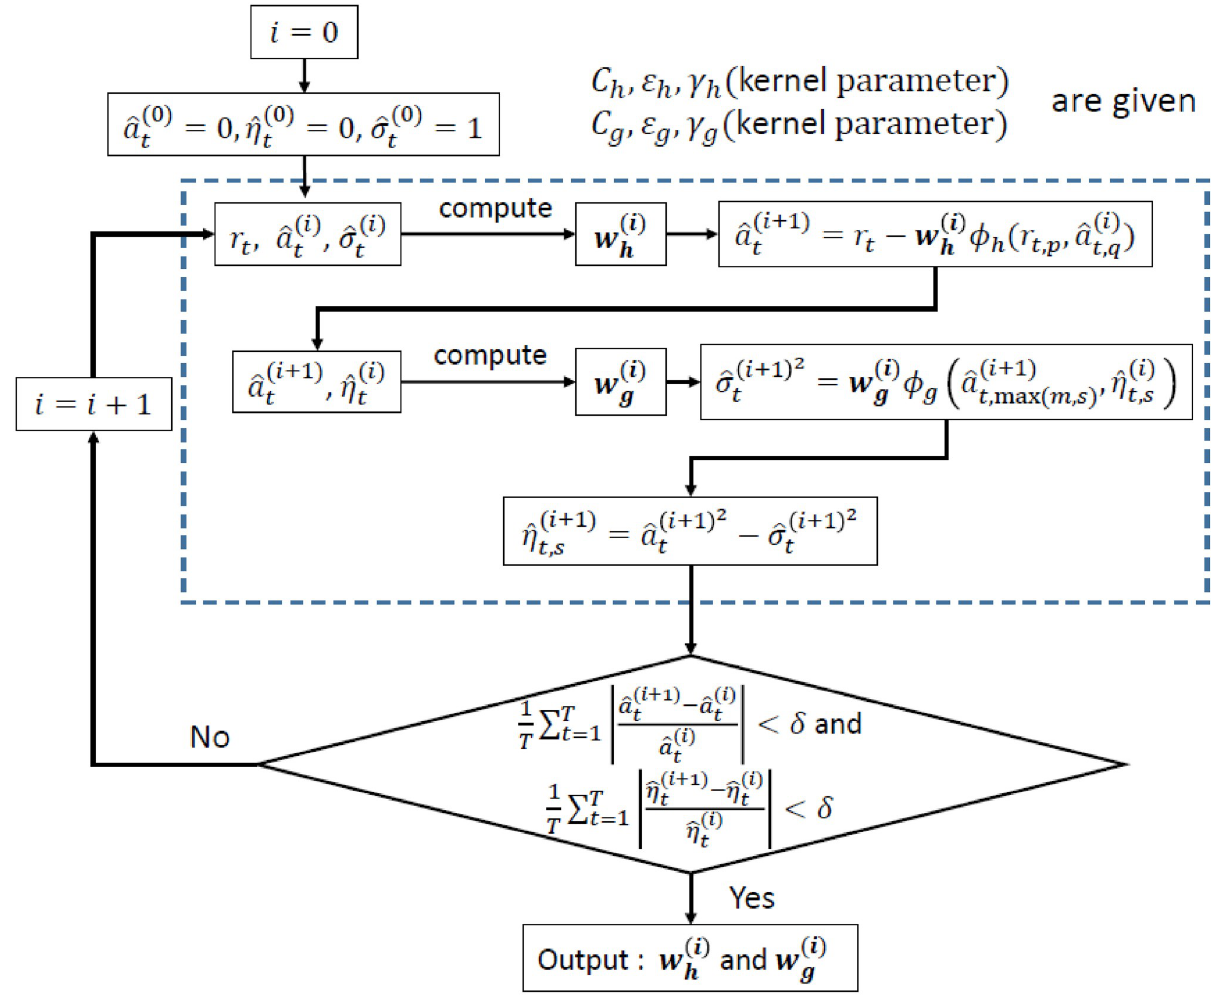
Fig 1. ARE of the SVR-ARMA-GARCH